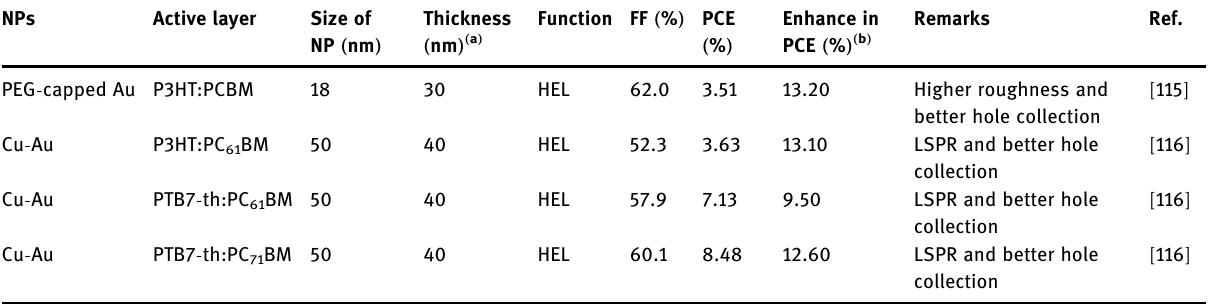
Table 9: Device characteristics of OPVs with hybrid NPs doped PEDOT:PSS NPs Active